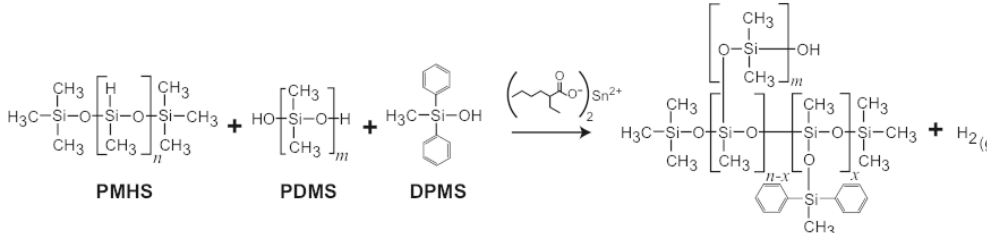
Figure 5. Chemical structures of starting materials, curing agent, and final SX358 foam. The H 2 (g) released during cross-linking produces the stochastic pore network of the open cell